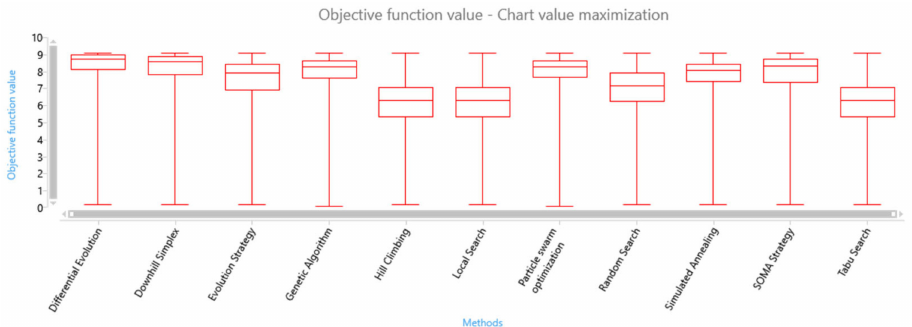
Figure 12. Box plot of solution candidate’s objective function values found by optimisation methods— the second termination criterion using the dimension of the search